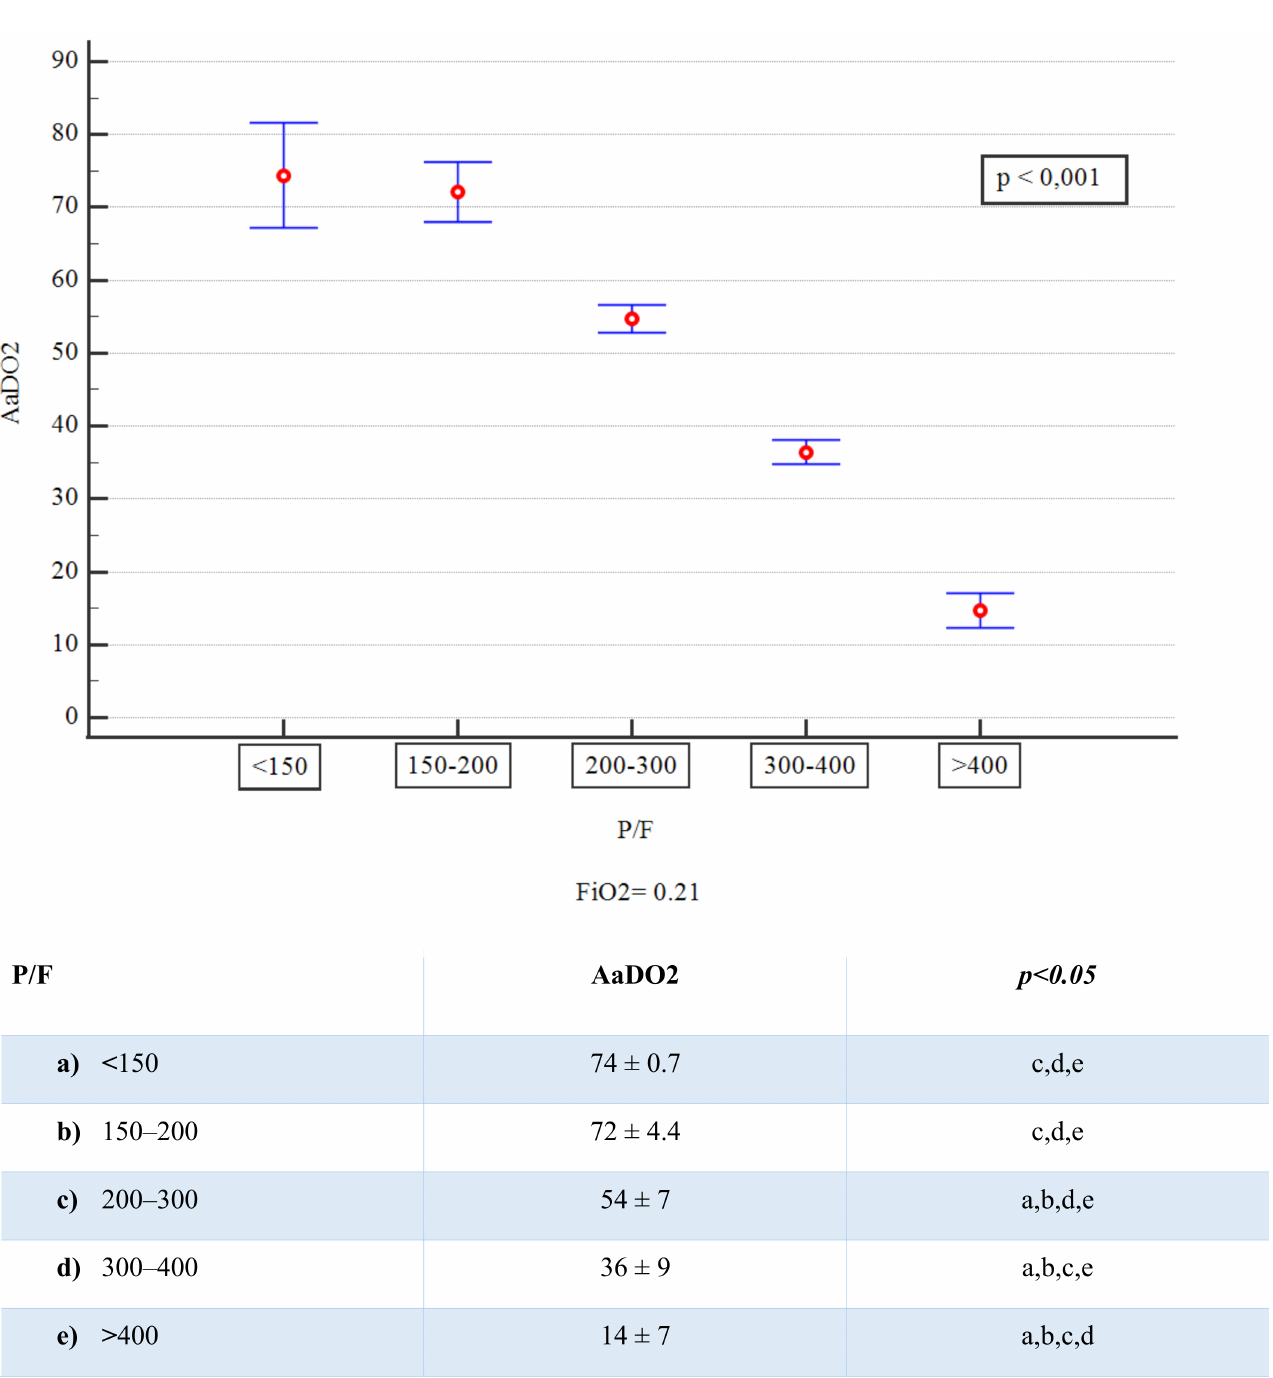
Figure 2. AaDO2 mean values and P/F